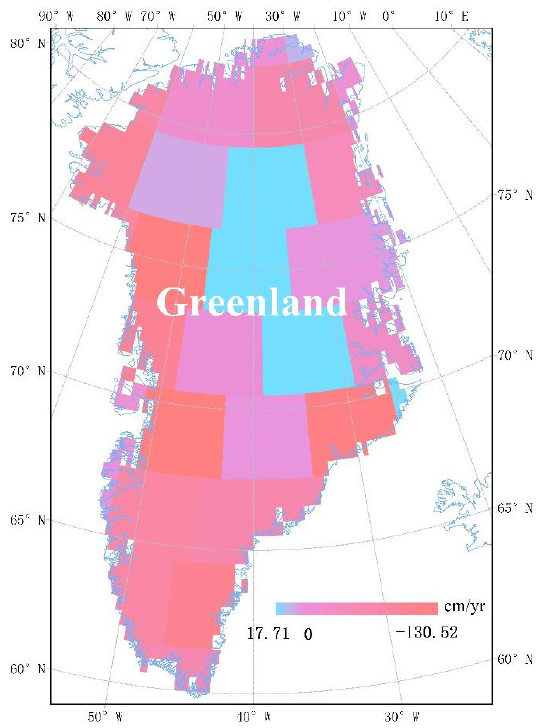
Figure 2. The rate of change of Greenland Ice Sheet mass variations (in Equivalent Water Thickness cm/yr).